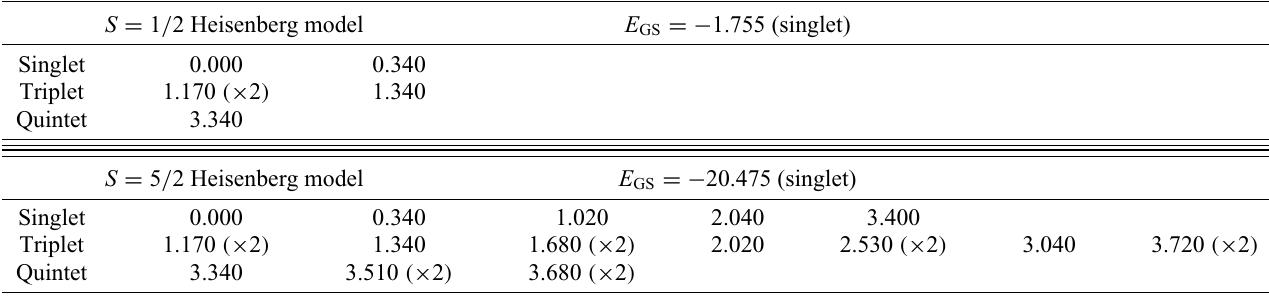
TABLE I. The excitation energy levels of the S = 1 / 2 and S = 5 / 2 Heisenberg models for the [4Fe-4S] cluster. The numbers in parentheses indicate the